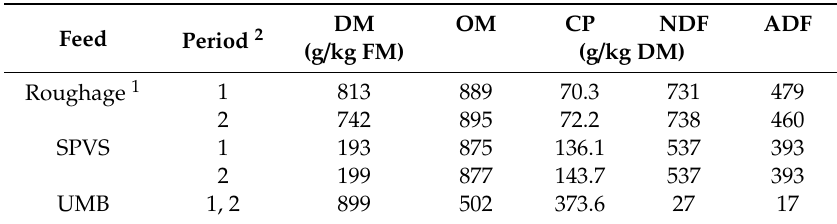
Table 1. Proximate composition of roughage 1 , sweet potato vine silage (SPVS), and urea-molasses blocks (UMB) o ff ered during the